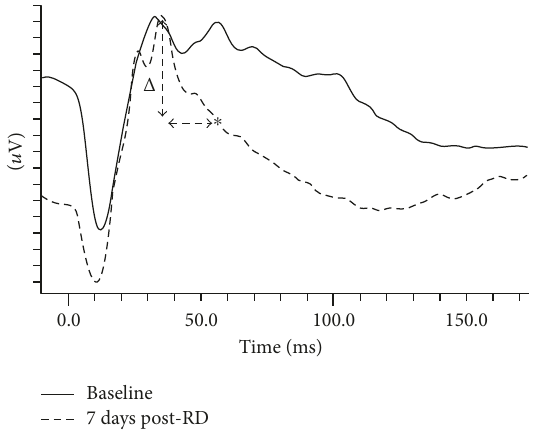
Figure 1: WDS measurement. Representative ERG traces (dark adapted, 10 cd ∗ s/m 2 ) of the same eye before (solid line) and 7 days postretinal detachment (dashed line). The traces are aligned at the b-wave peaks for ease of comparison; therefore the baseline (i.e., zero μ V) value of the vertical axis is not designated. One vertical increment = 10 μ V. The WDS di ff erence (vertical dashed arrow) is de fi ned as the amplitude di ff erence between the b-wave peak and the WDS peak. In many operated eyes, in which the WDS was abolished, the WDS was set as the recorded potential measured at the implicit time of the baseline WDS (designated with asterisk). Δ =di ff erence; WDS=wavefront of the descending slope; RD =retinal detachment.